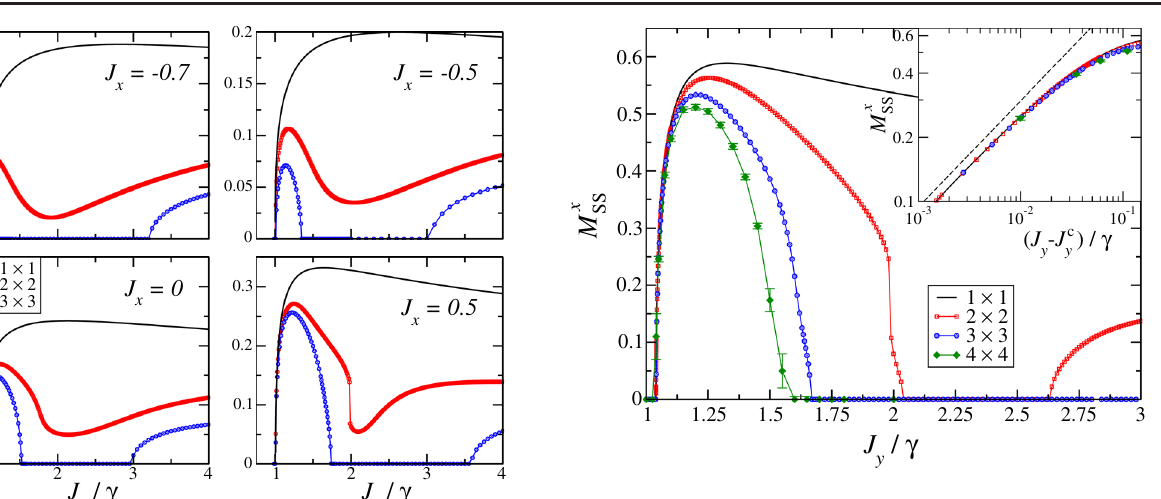
FIG. 10. Same analysis as in Fig. 9, but for J x ¼ 0 . 9 . In the inset, we show the rescaled data close to the left phase transition; the straight dashed line denotes a square-root behavior as in Eq. (22) and is plotted as a guide to the